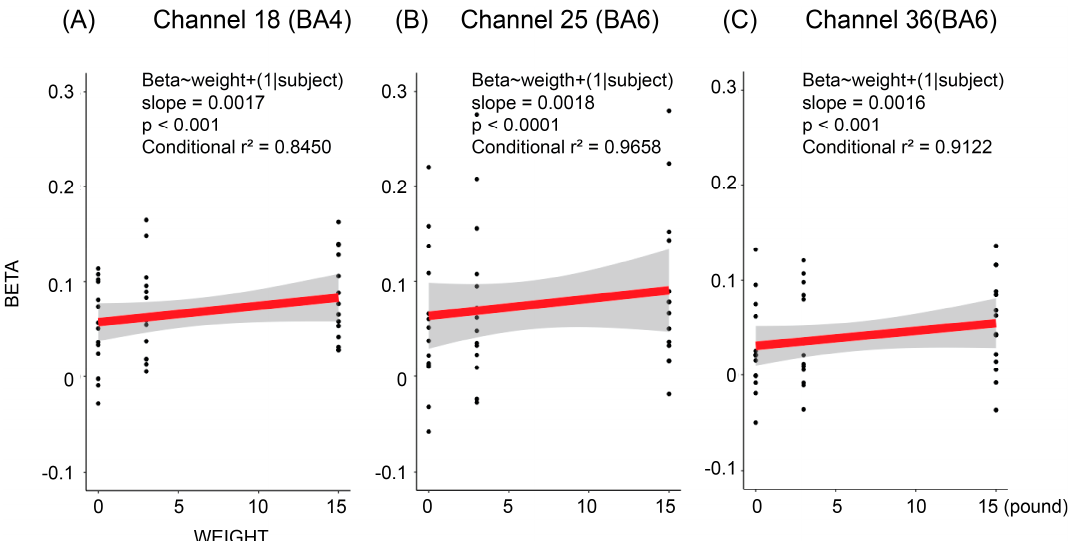
Figure 6. Representative examples of channel-wise correlation. ( A ) Channel 18, located in BA4. ( B ) Channel 25, located in BA6. ( C ) Channel 36, located in BA6. Representative channels were chosen based on the p -values of the mixed-effect model. We plotted the sample-regression line to display the overall tendency. Table 2. Statistical details of channel-wise correlation.